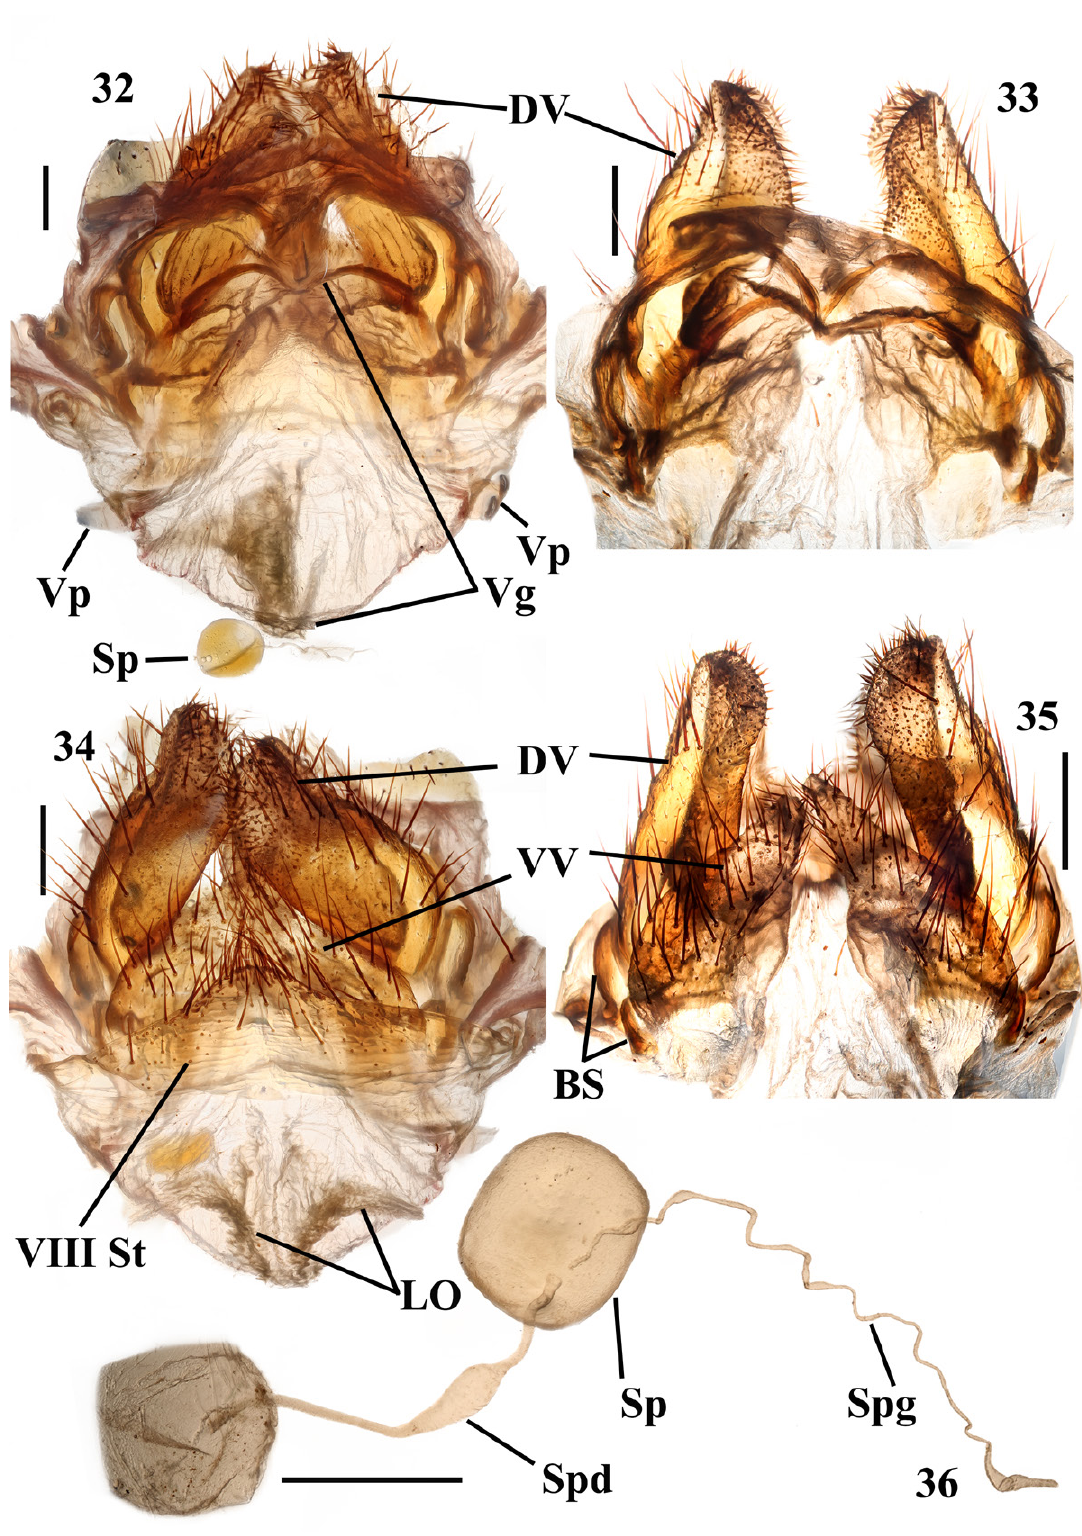
Figs 32–36. Oryctopterus varuna sp. nov., female genitalia. Paratype (NBAIR). 32 . Dorsal view. 33 . Dorsal view (valves separated). 34 . Ventral view. 35 . Ventral view (without sternite VIII). 36 . Spermatheca Abbreviations: see Material and methods. Scale bars = 1